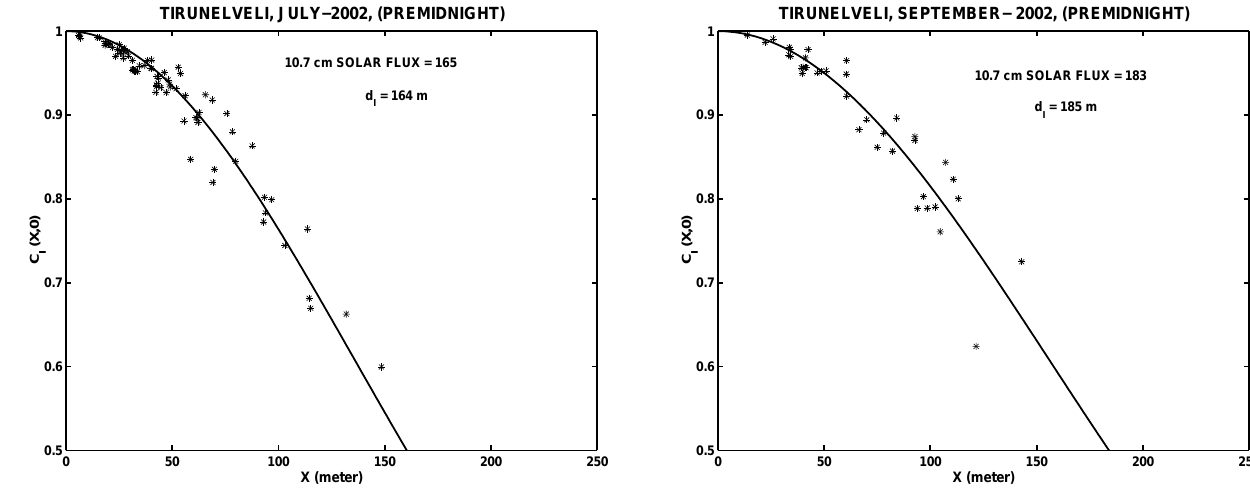
Fig. 3. C I (x, 0 ) as a function of x for the pre-midnight period of weak scintillations during September